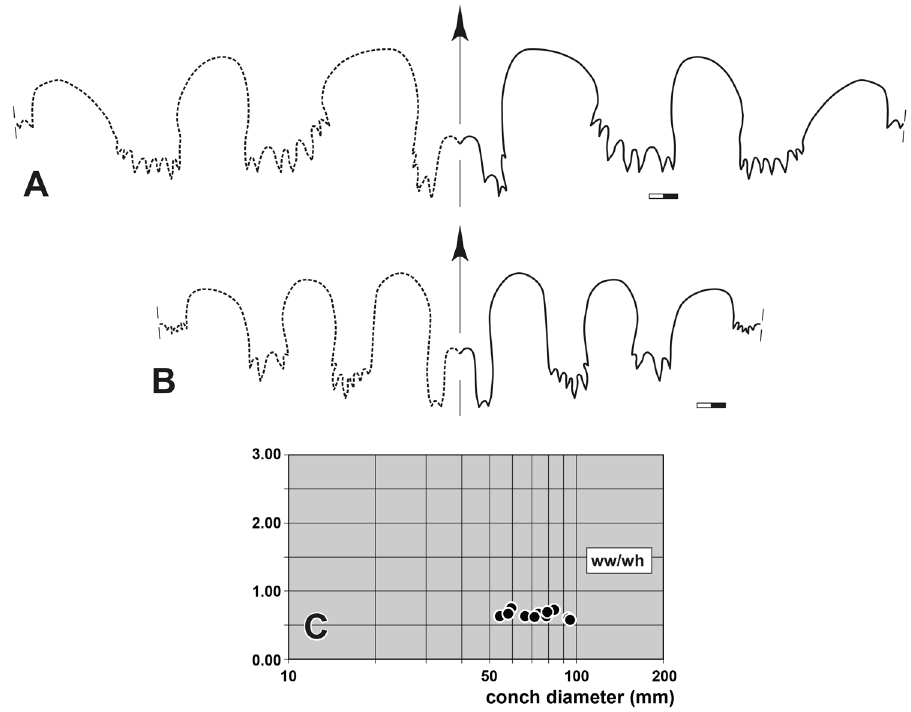
Fig. 52. Lutites lyriformis Korn & Hairapetian gen. et sp. nov. A . Suture line, holotype MB.C.29995, at 58.3 mm dm, 23.1 mm wh. B . Suture line, paratype MB.C.29997, at 53.8 mm dm, 19.0 mm wh. C . Whorl profile proportions. Abbreviations: see Material and methods. Scale bar units = 1